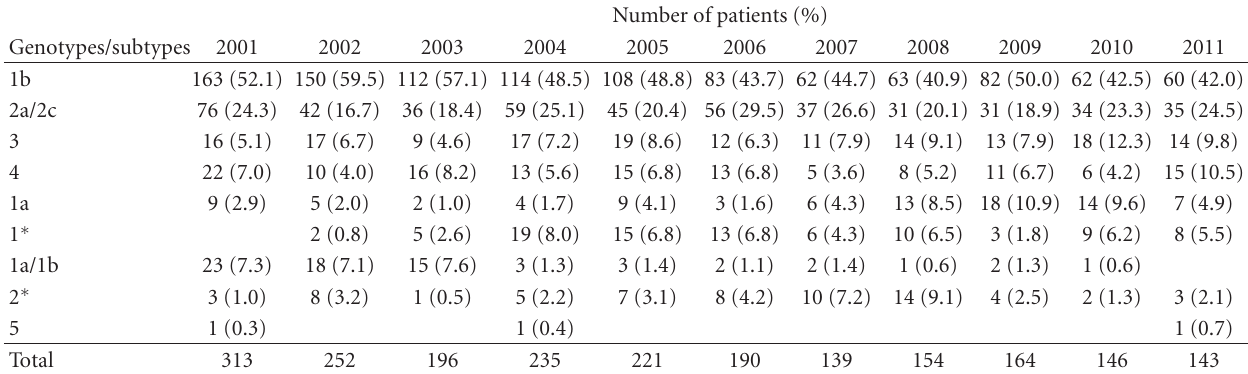
Table 1: Distribution of HCV genotypes evaluated in 2,153 patients from 2001 to